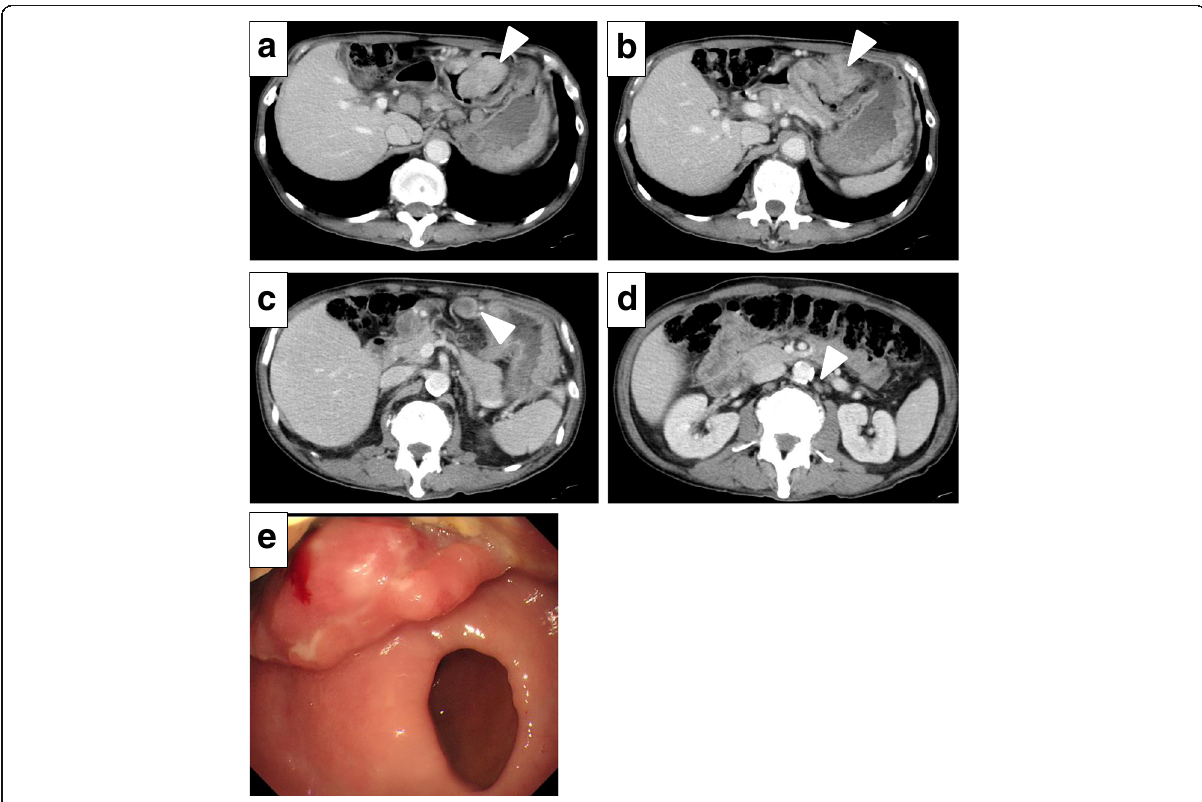
Fig. 1 Examination images of the gastric cancer before the operation. a Abdominal computed tomography revealing an enhancing mass in the gastric antrum ( white arrow head ). b A more distal section of the gastric tumor with evidence of pyloristenosis ( white arrow head ). c Peri-gastric lymph node enlargement ( white arrow head ). d Enlarged para-aortic lymph nodes ( white arrow head ). e Esophagogastroduodenoscopy